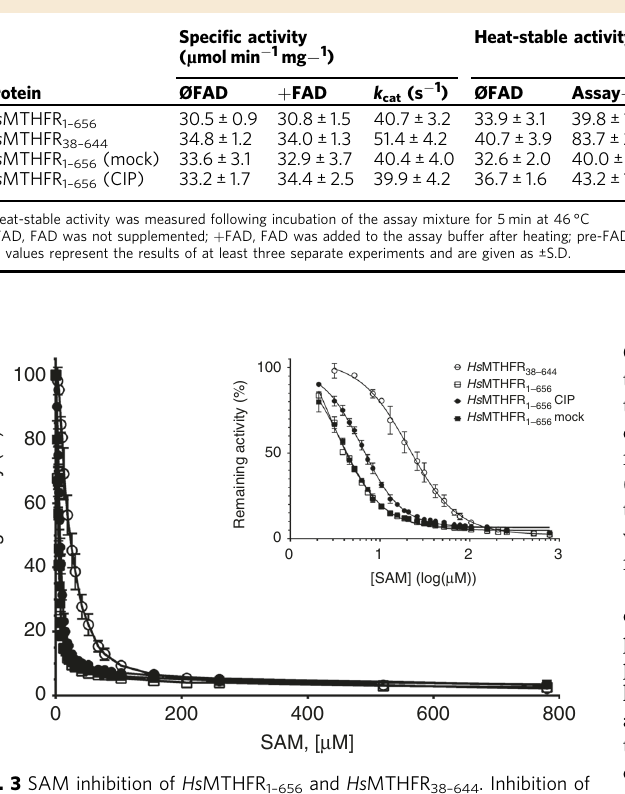
Table 1 Kinetic characterization of Hs MTHFR